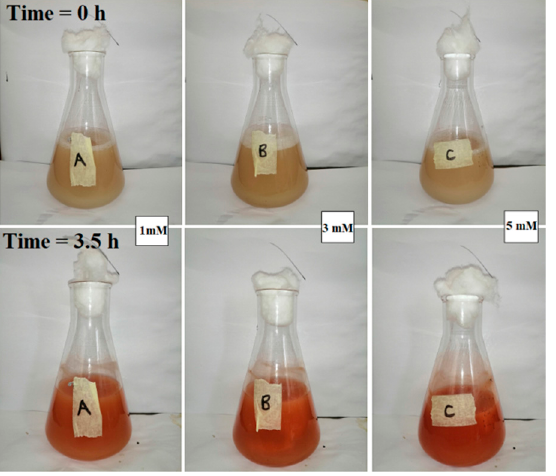
Figure 3. Colour variations in SeO 32 − reduction at the start (0 h) and the end (3.5 h).